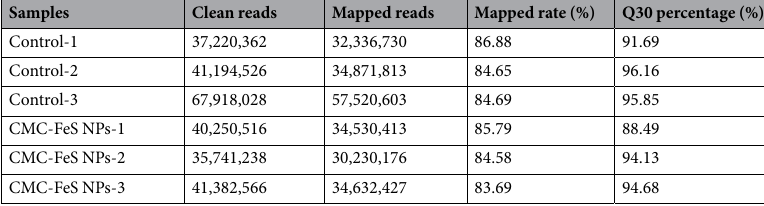
Table 1. Summary of sequence data generated for zebrafish transcriptome and quality